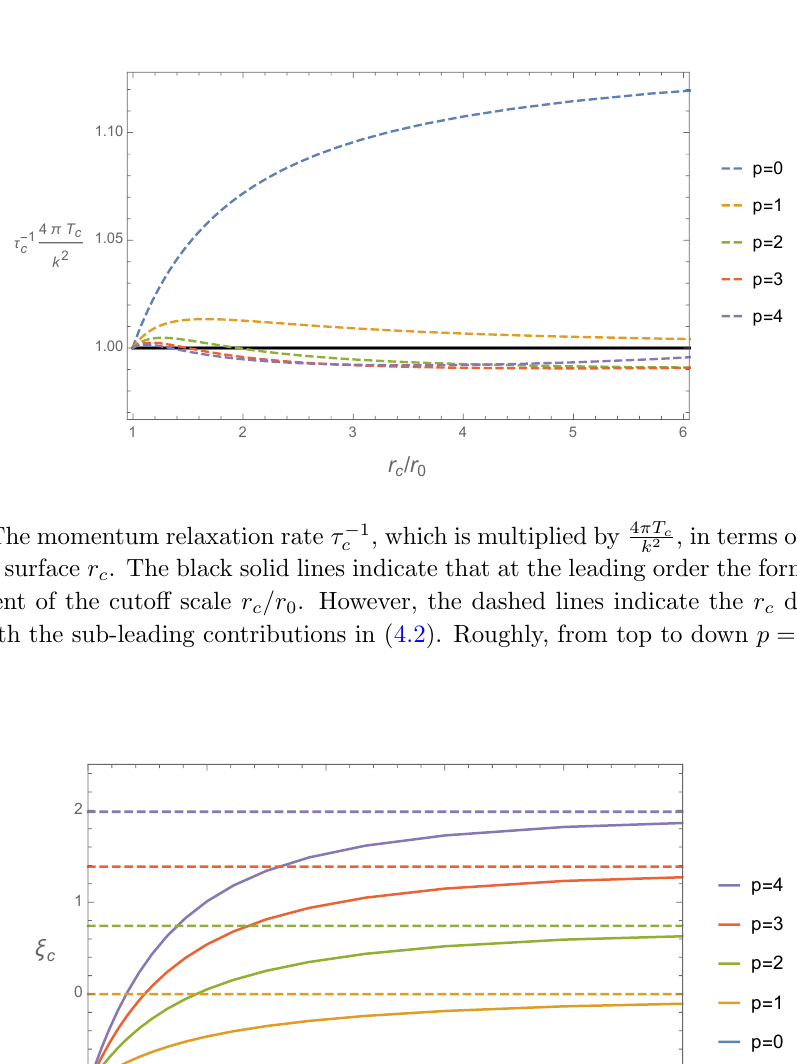
Figure 3 . The dimensionless coe(cid:14)cient (cid:24) c in terms of the position of the cuto(cid:11) surface r c =r 0 . The holographic (cid:13)uids live in the p + 1 dimensional spacetime, and p = 0 ; 1 ; : : : ; 4 from the bottom up. (cid:24) c is the key coe(cid:14)cient to indicate the sub-leading correction to the momentum relaxation rate in (4.2). The solid lines are the direct plots of (cid:24) c in (3.57), and the dashed lines are taken from (cid:24) 1 in (4.9). For the case of p = 0 and p = 1, (cid:24) c is always negative. They agree with the plots in (cid:12)gure 2 after considering (4.2).